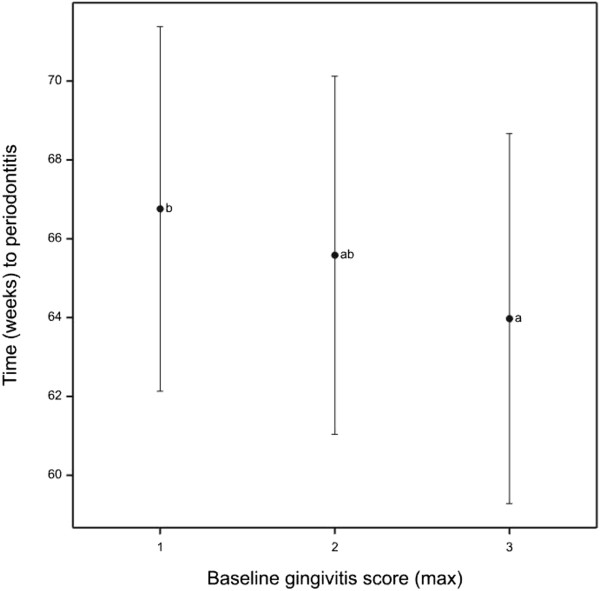
Average time to periodontitis by starting gingivitis score. Estimated average time to periodontitis for teeth by baseline maximum gingivitis scores with 95% confidence intervals. Letters represent Tukey HSD homogenous groups at the 5% level.